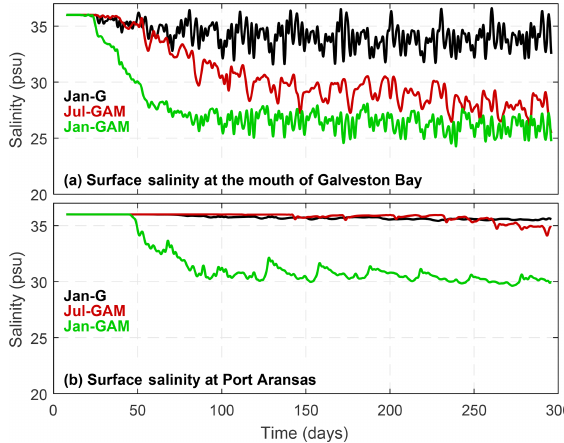
Figure 13. Subtidal surface salinity at the mouth of (a) Galveston Bay and (b) Aransas Bay for three numerical